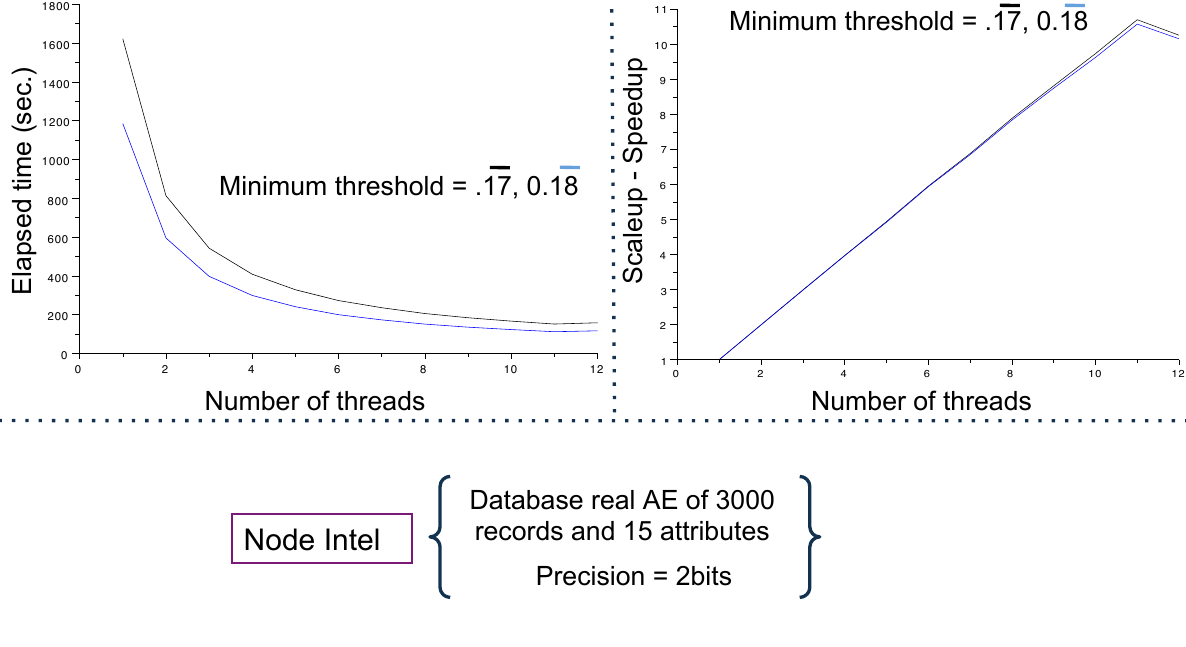
Figure 12. Execution time and Speedup related to the number of threads on Intel nodes for real database of 3000 lines at precision 2 bits with minimum threshold values 0.17 and 0.18.